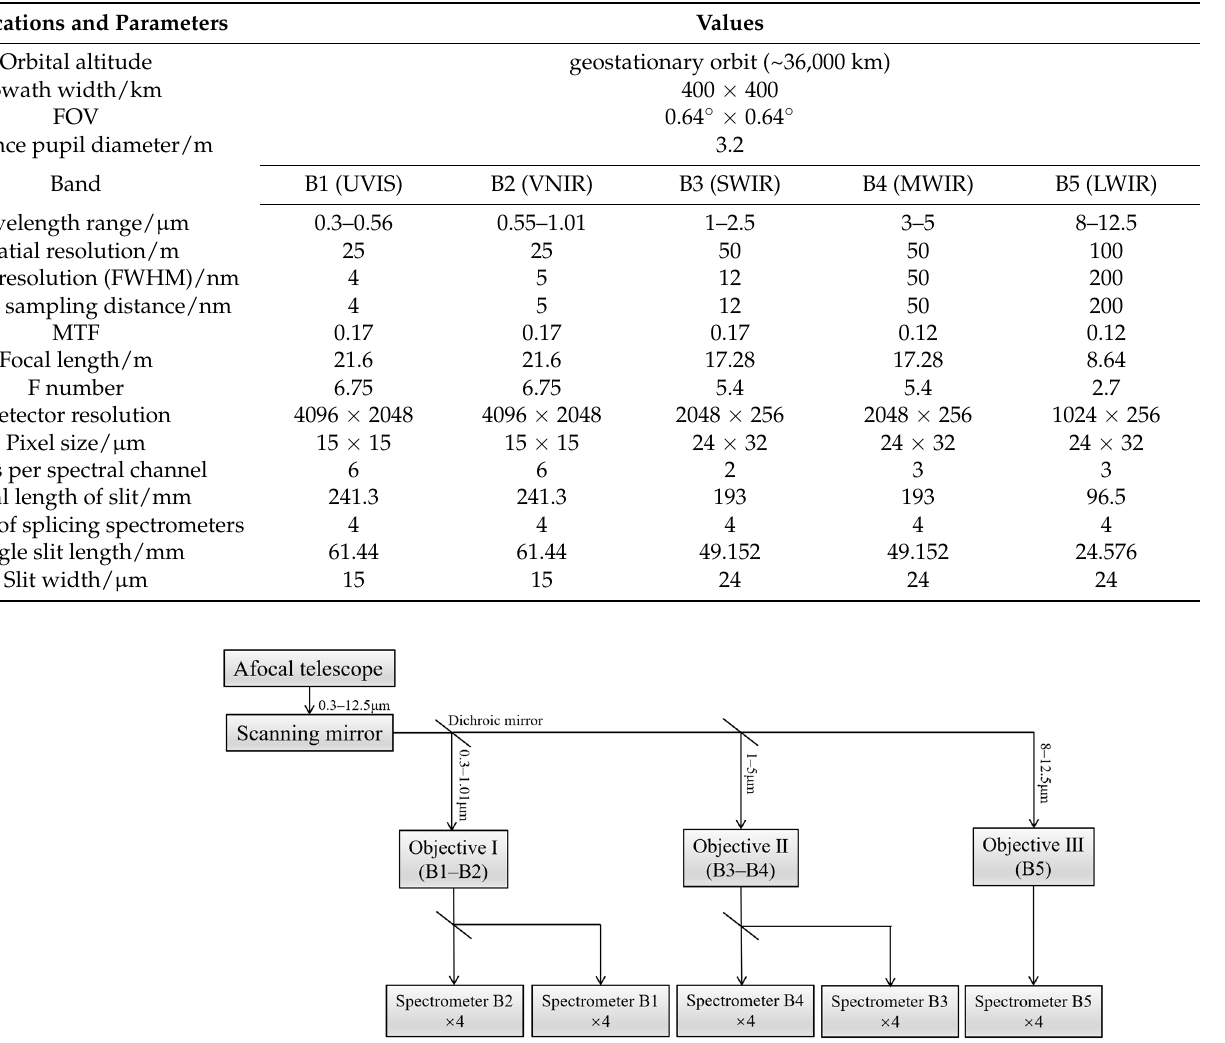
Figure 1. Layout block diagram of GeoFWHIS. Table 2. Comparison of specifications between GeoFWHIS and some current satellite sensors in